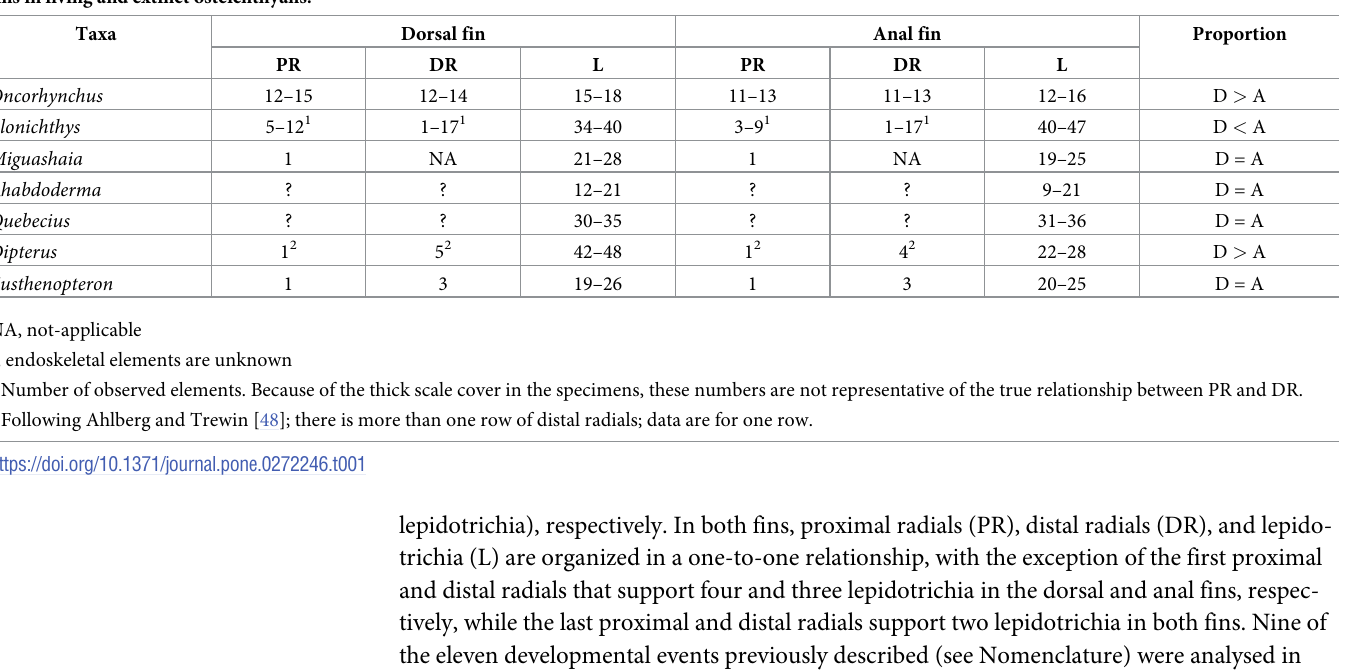
Table 1. Meristic counts for the skeletal elements, proximal radials (PR), distal radials (DR) and lepidotrichia (L) and proportions of the dorsal (D) and anal (A) fins in living and extinct